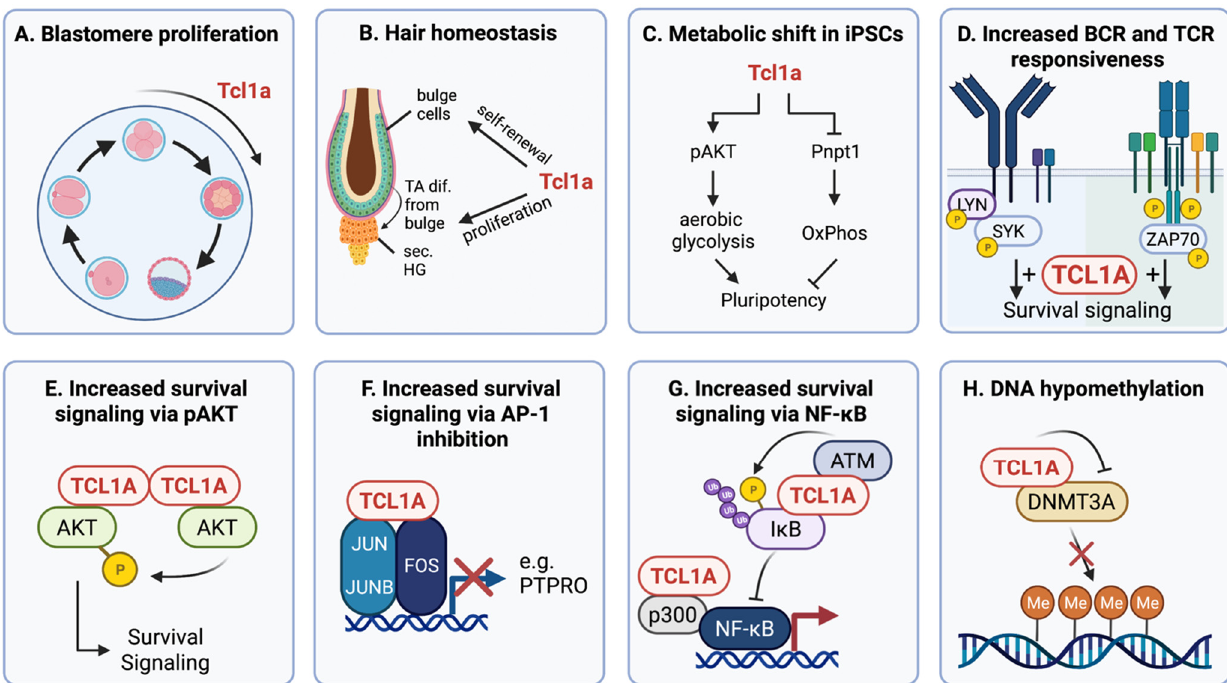
Figure 1. TCL1A functions as a pleiotropic adapter molecule in stemness and survival signaling. Note that “roles” and “modes of actions” at various levels (e.g., cell function, impacted pathway, concise molecular interaction) are highlighted and are in part artificially separated (i.e., E part of C and D): ( A ) in murine blastomeres, Tcl1a is important in early proliferation, as Tcl1a − / − mice show a block of blastomere development at the 8-cell stage [9]; ( B ) Tcl1a regulated hair growth, as shown by hair loss in Tcl1a − / − mice. Tcl1a is expressed in the bulge cells (stem cell niche) and in the secondary hair germ/transit-amplifying (TA) cells (proliferative structure) during the catagen–telogen (resting phase) transition and early anagen stage (regeneration phase). In Tcl1a − / − mice, the bulge cells show reduced expression of the stem cell marker CD34. Furthermore, a Tcl1a knockout led to reduced proliferation of TA cells, needed for new hair formation [59]; ( C ) upregulation of Tcl1a leads to metabolic shifts toward aerobic glycolysis via activation of Akt and repression of Pnpt1, thereby contributing to pluripotency of induced pluripotent stem cells (iPSCs) [60]; ( D ) in cells of chronic lymphocytic leukemia (CLL) and T-cell prolymphocytic leukemia (T-PLL), TCL1A increases the responsiveness to B-cell receptor (BCR) and T-cell receptor (TCR) stimulation, respectively, by a kinase activating effect [24,26,61]; ( E ) interaction of the TCL1A homodimer with AKT molecules leads to augmented trans-phosphorylation and catalytic activity of the oncogenic Ser/Thr kinase AKT, resulting in increased survival signaling [62]; ( F ) the interaction of TCL1A with AP-1 components—namely, JUN, JUNB, and FOS, leads to impaired AP-1 signaling and thereby sustained anti-apoptotic signals [11]; ( G ) TCL1A interacts with I κ B and mediates its phosphorylation via ATM, leading to its subsequent ubiquitination-dependent degradation. Inhibition of this negative regulator I κ B causes increased NF- κ B signaling, which is additionally strengthened by the TCL1A-p300 interaction [11]; ( H ) physical interaction of TCL1A with DNMT3A reduces the methyltransferase activity of DNMT3A, which leads to a higher number of hypomethylated genomic regions [63], which is implicated in the pathogenesis of CLL [64]. This figure was created using BioRender.com (accessed on 22 October